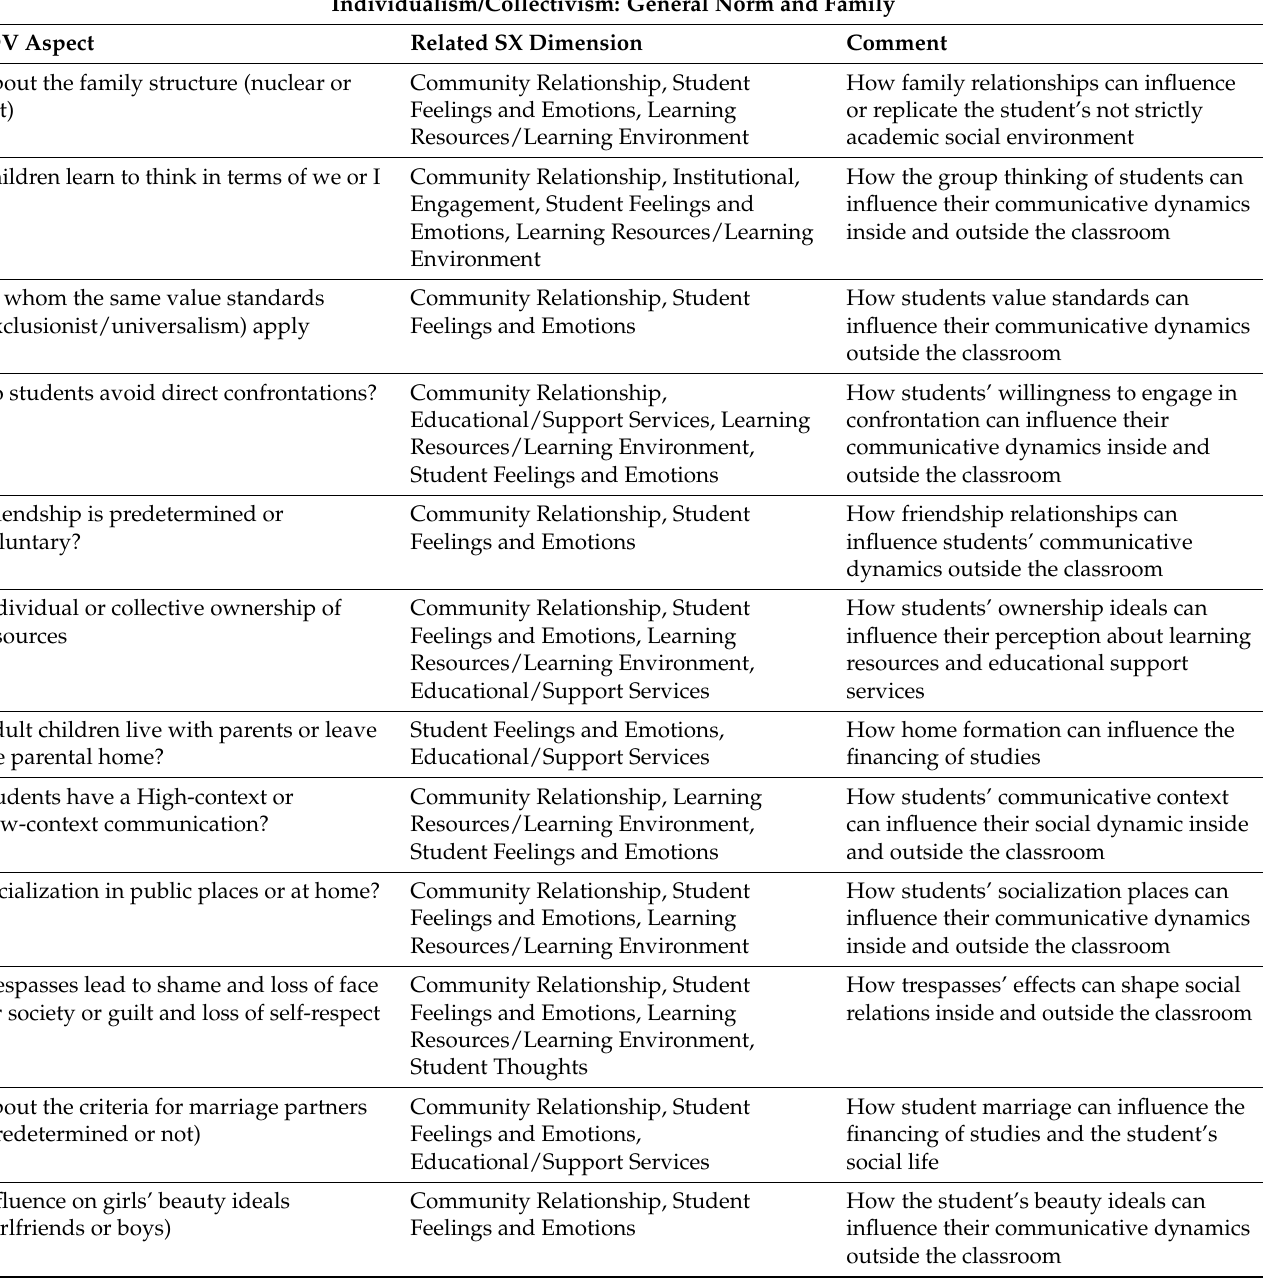
Table 3. General norm and family of individualist/collectivist societies in SX.